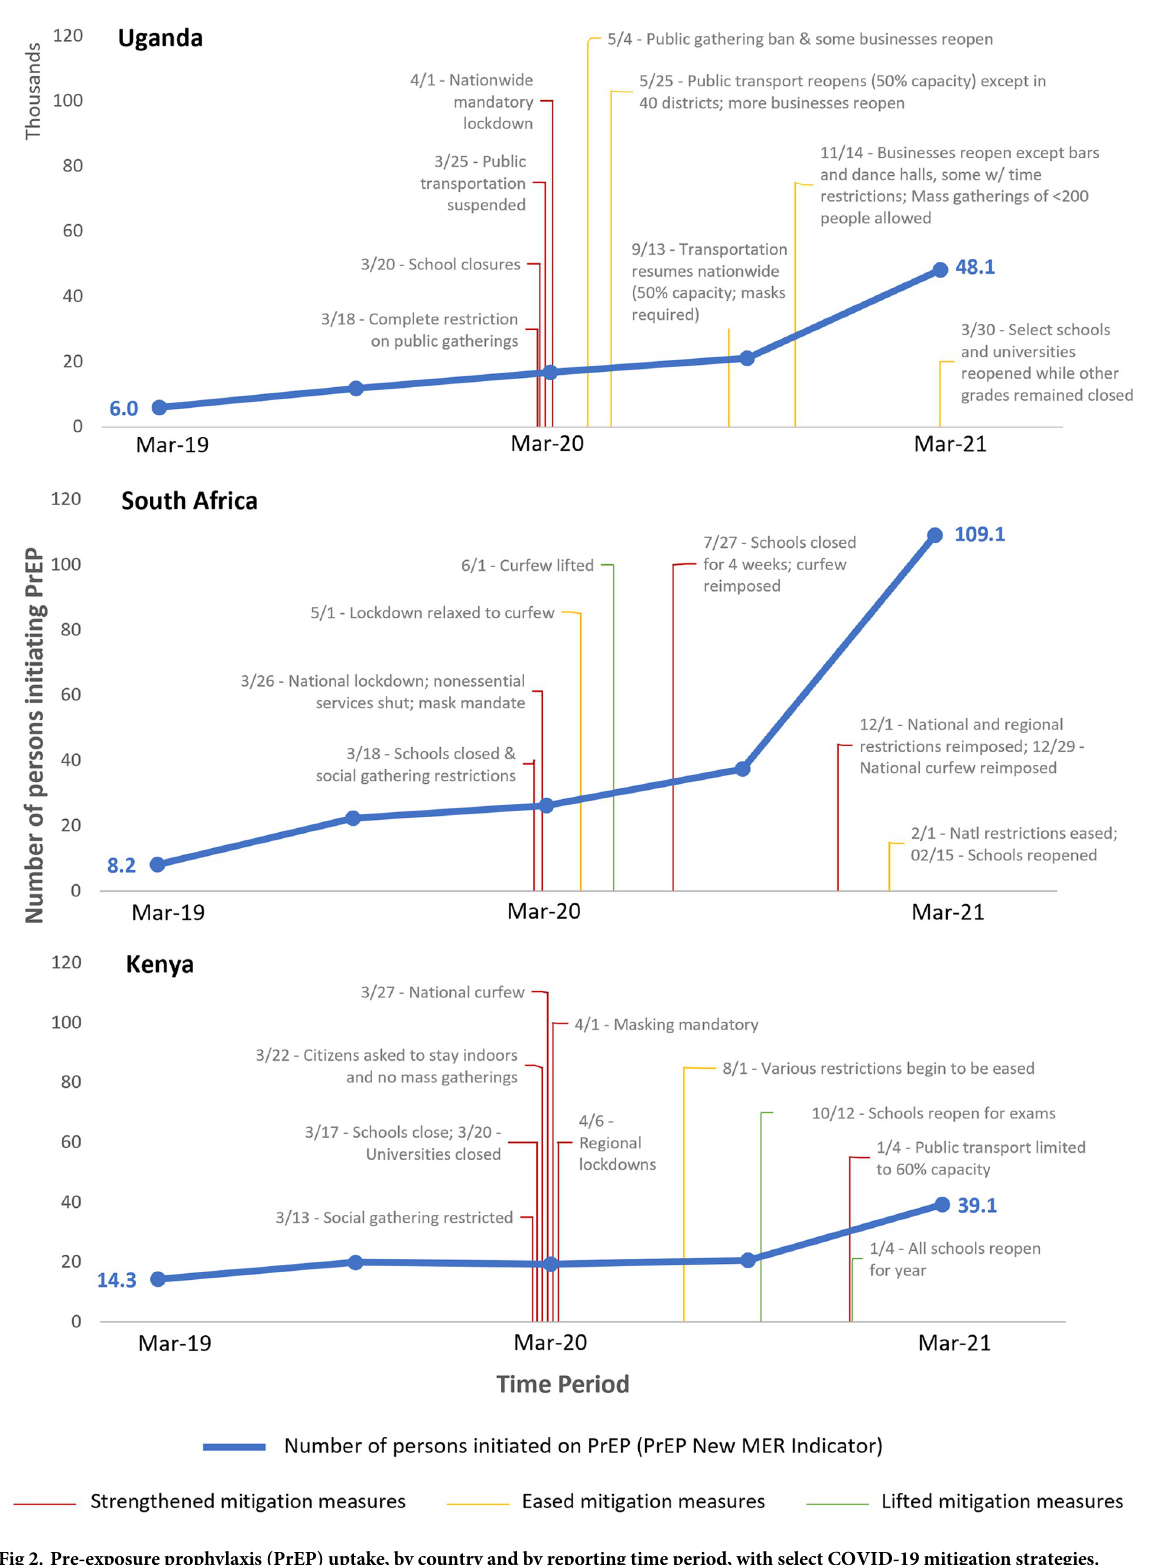
Fig 2. Pre-exposure prophylaxis (PrEP) uptake, by country and by reporting time period, with select COVID-19 mitigation strategies.